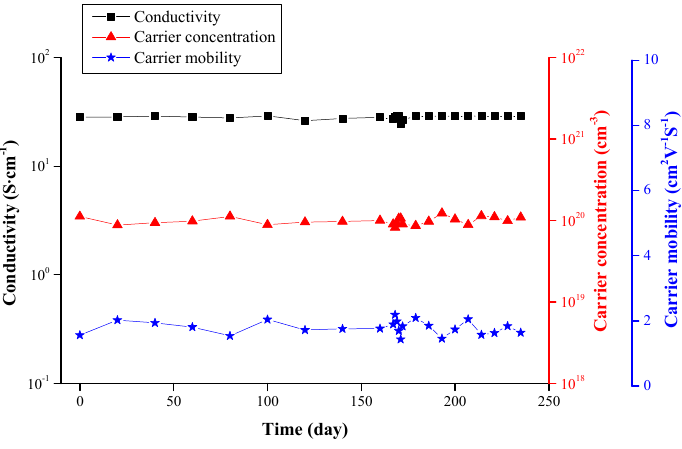
Figure 8. The electrical time stability of the ZnO film with 4.29 at. % Ga at ambient temperature.